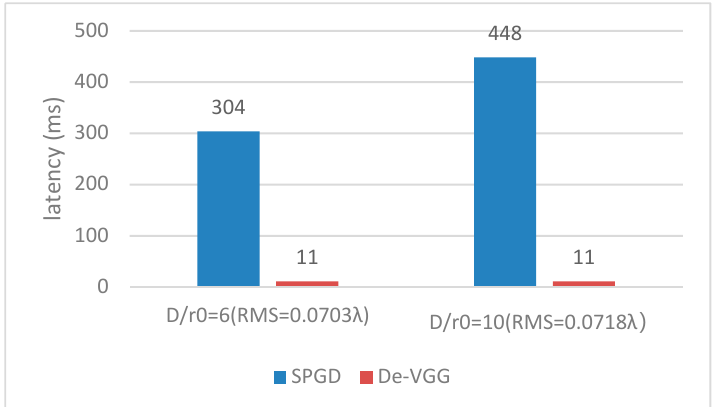
Figure 7. Root mean square (RMS) with latency of the stochastic parallel gradient descent (SPGD) algorithm and De-VGG .